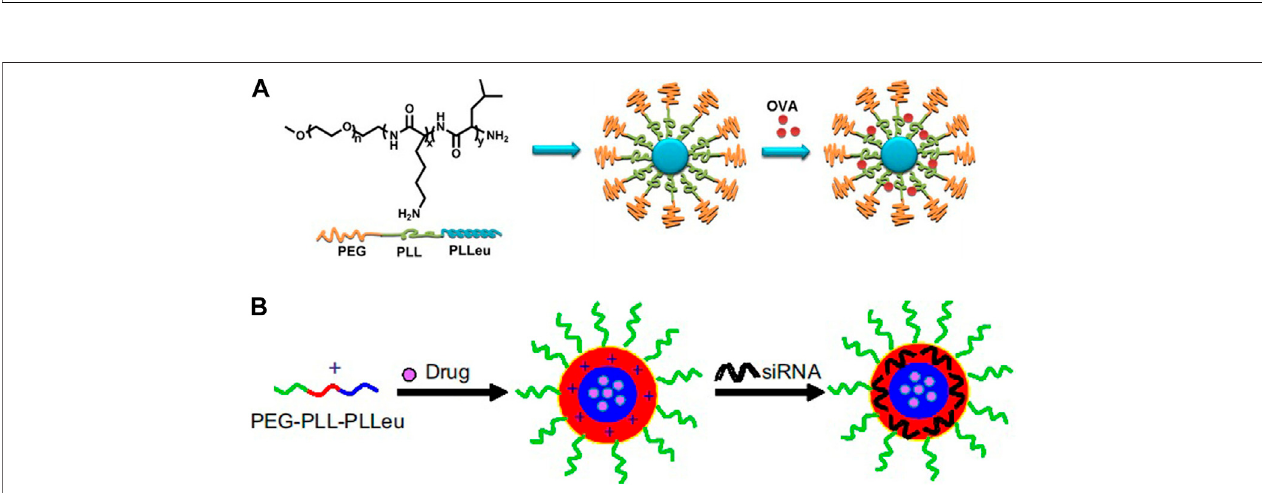
FIGURE2| SchematicillustrationofPEG-PLL-PLLeumicellesloadedwithOVA (A) (Luoetal.,2013)orsiRNAanddrug (B) (Zhengetal.,2013).Abbreviation:PEG, poly(ethylene glycol); PLL, poly(L-lysine); PLLeu, poly(L-leucine); OVA, ovalbumin.